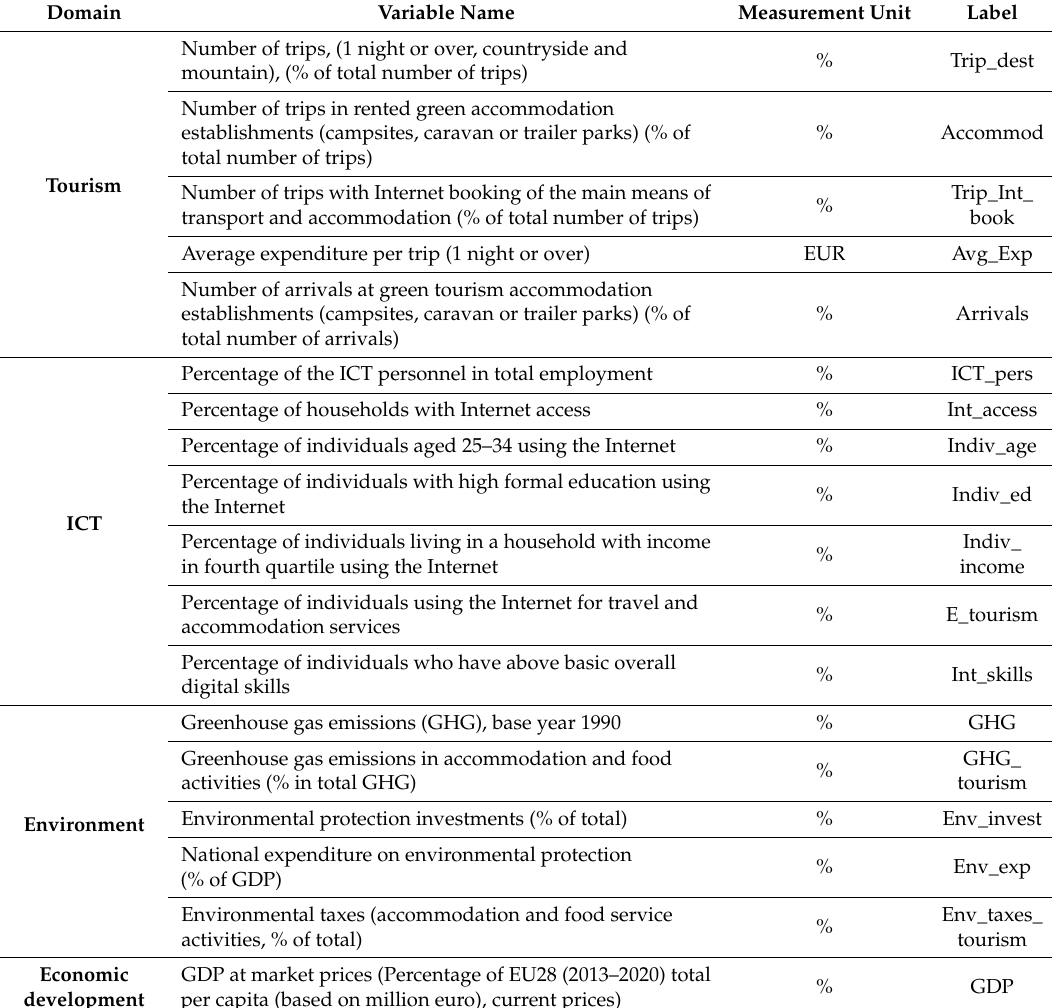
Table 1. List of variables included in the